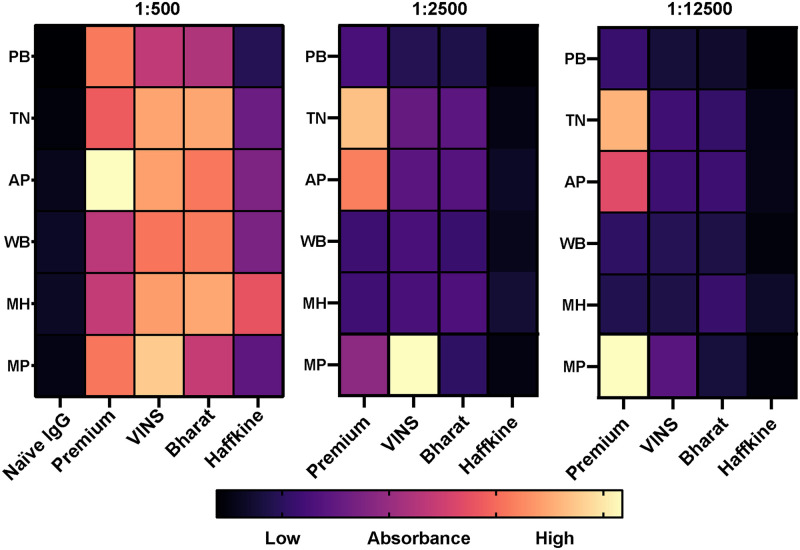
Immunological cross-reactivity of commercial Indian antivenoms against the pan-Indian populations of D. russelii venoms.Heatmaps, shown here, quantify the binding of commercial Indian antivenoms to the venoms of pan-Indian populations of D. russelii. Multiple dilutions of antivenoms (1:500, 1:2500 and 1:12500) were tested in indirect ELISA experiments. Non-specific binding of naive horse IgGs (1:4 dilution) to Daboia venoms is also shown in the first plate for reference. A gradient colour scale has been shown indicating the degree of binding from low (black) to high (cream). PB: Punjab; TN: Tamil Nadu; AP: Andhra Pradesh; WB: West Bengal; and MH: Maharashtra; MP: Madhya Pradesh.